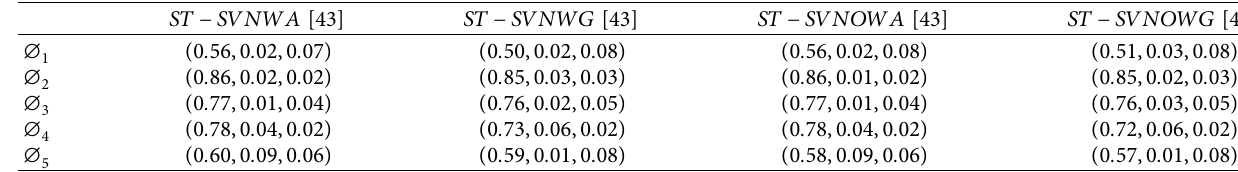
Table 9: Existing aggregated SVN information.